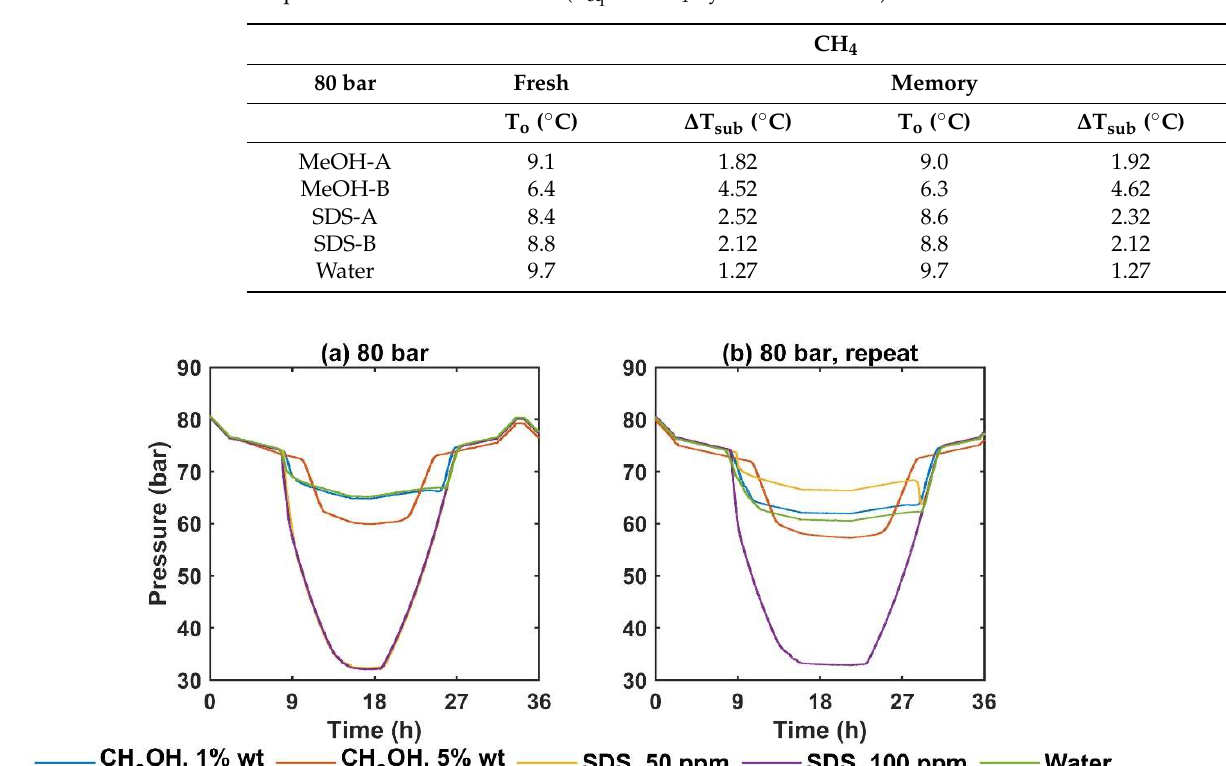
Table 1. Averaged onset nucleation temperature T o (°C) and subcooling (∆T sub ) for CH 4 hydrate in the presence of MeOH and SDS (T eq for CH 4 hydrate = 10.92 °C). CH 4 80 bar Fresh Memory T o (°C) ΔT sub (°C) T o (°C) ΔT sub (°C) MeOH-A 9.1